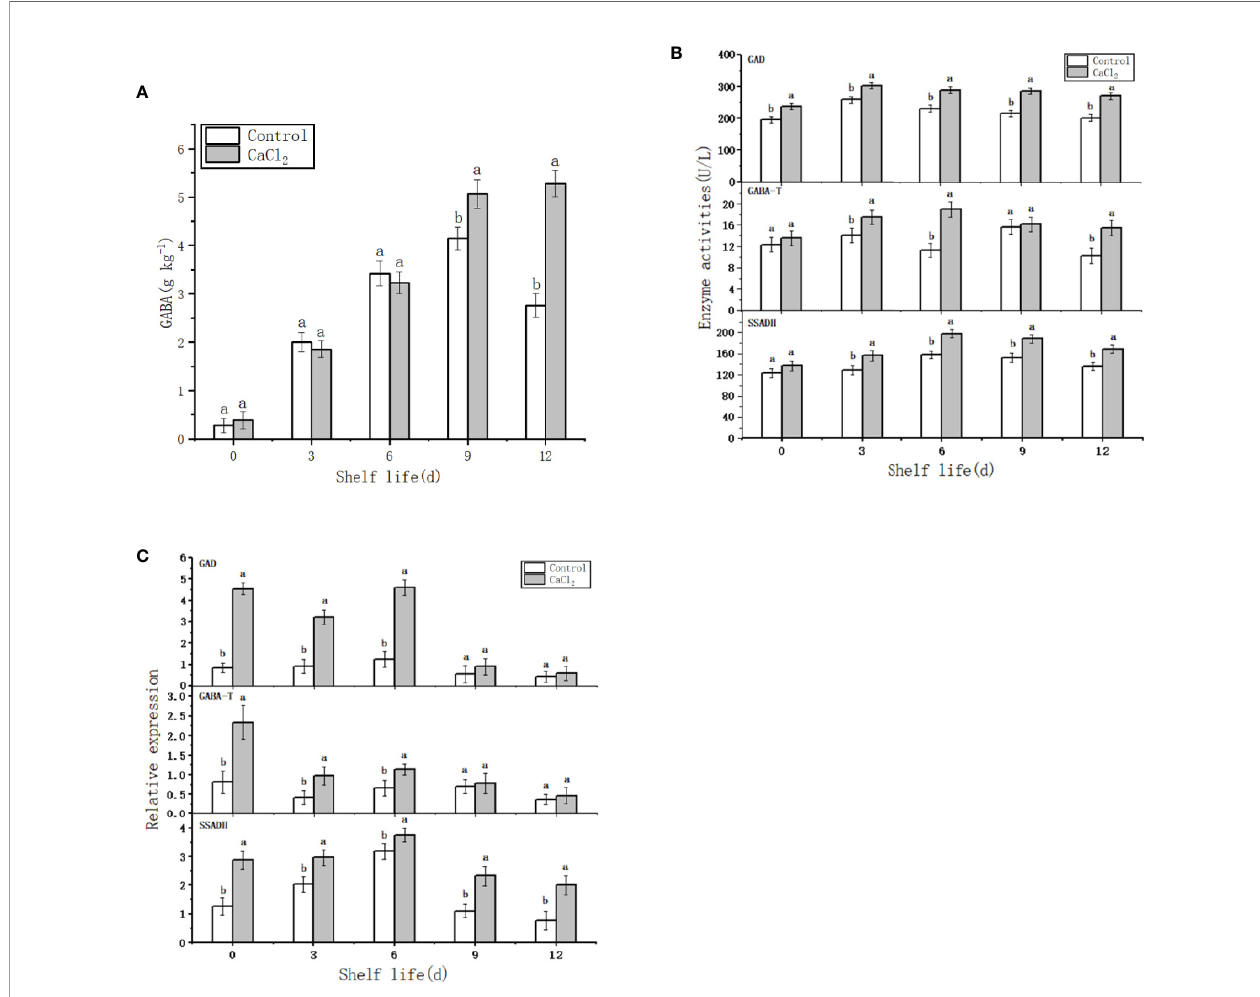
FIGURE 4 | GABA (A) , GAD, GABA-T and SSADH activities (B) and relative expression of GAD, GABA-T, and SSADH (C) in “ Nangou ” pear fruit during the 0, 3, 6, 9, and 12 days at 20°C after cold storage. Means ± SE of three replicate experiments are shown. Means with different letters are signi fi cantly different between the treatments and control ( p